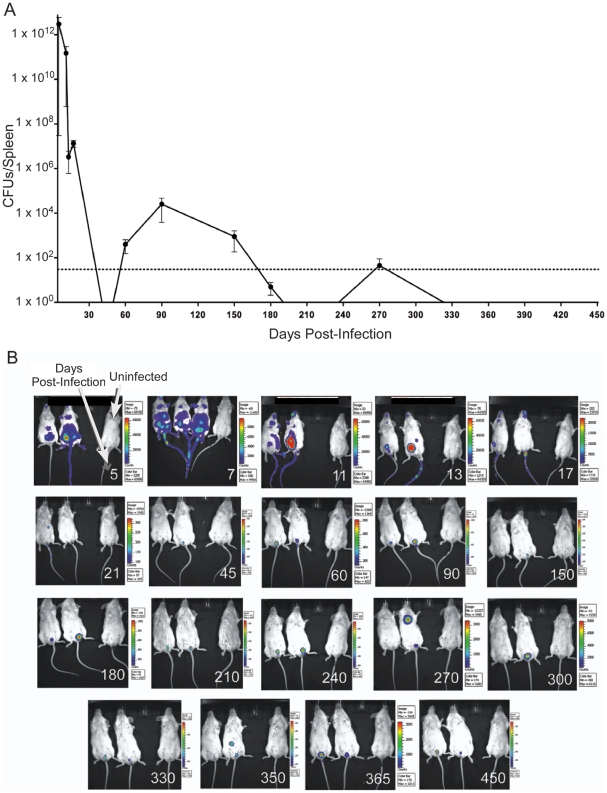
Persistence of infection.BALB/c mice were infected with 107 bioluminescent Brucella melitensis GR023. A) Colony forming units were determined by culturing serial dilutions of lysed splenocytes for 3–5 days at 37°C. B) Images were captured with a ten minute exposure on an IVIS Imaging System. The rainbow scale of luminescence for each image is in approximate photons. Age-matched control mice are shown in the rightmost position of each individual photo. The day post infection when the images were collected is noted in the bottom right corner of each frame.